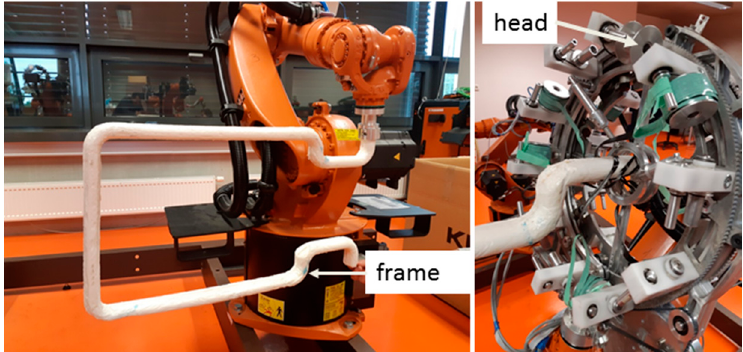
Figure 16. Test 1—Non-bearing core frame connected to end-effector of industrial robot KUKA KR 16-2 ( left ). Testing of passage of the frame through fiber-processing head ( right ).